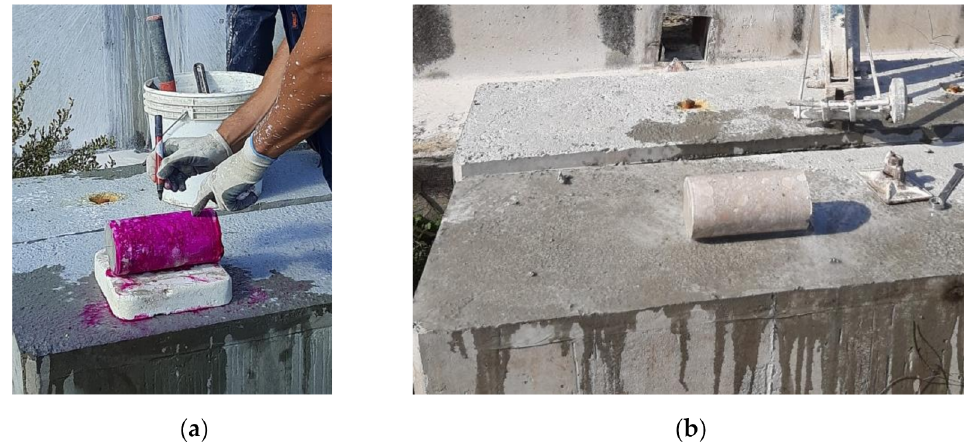
Figure 8. Samples B2_1 after phenolphthalein spraying ( a ) and sample B2_2 before spraying ( b